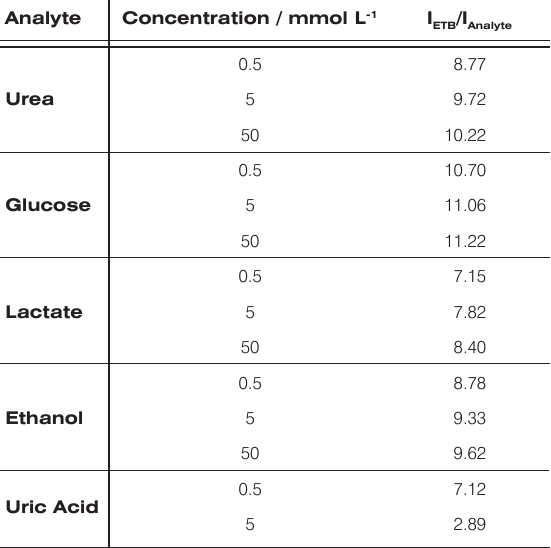
Table 1. Relation between electrode response for ETB and interferents.